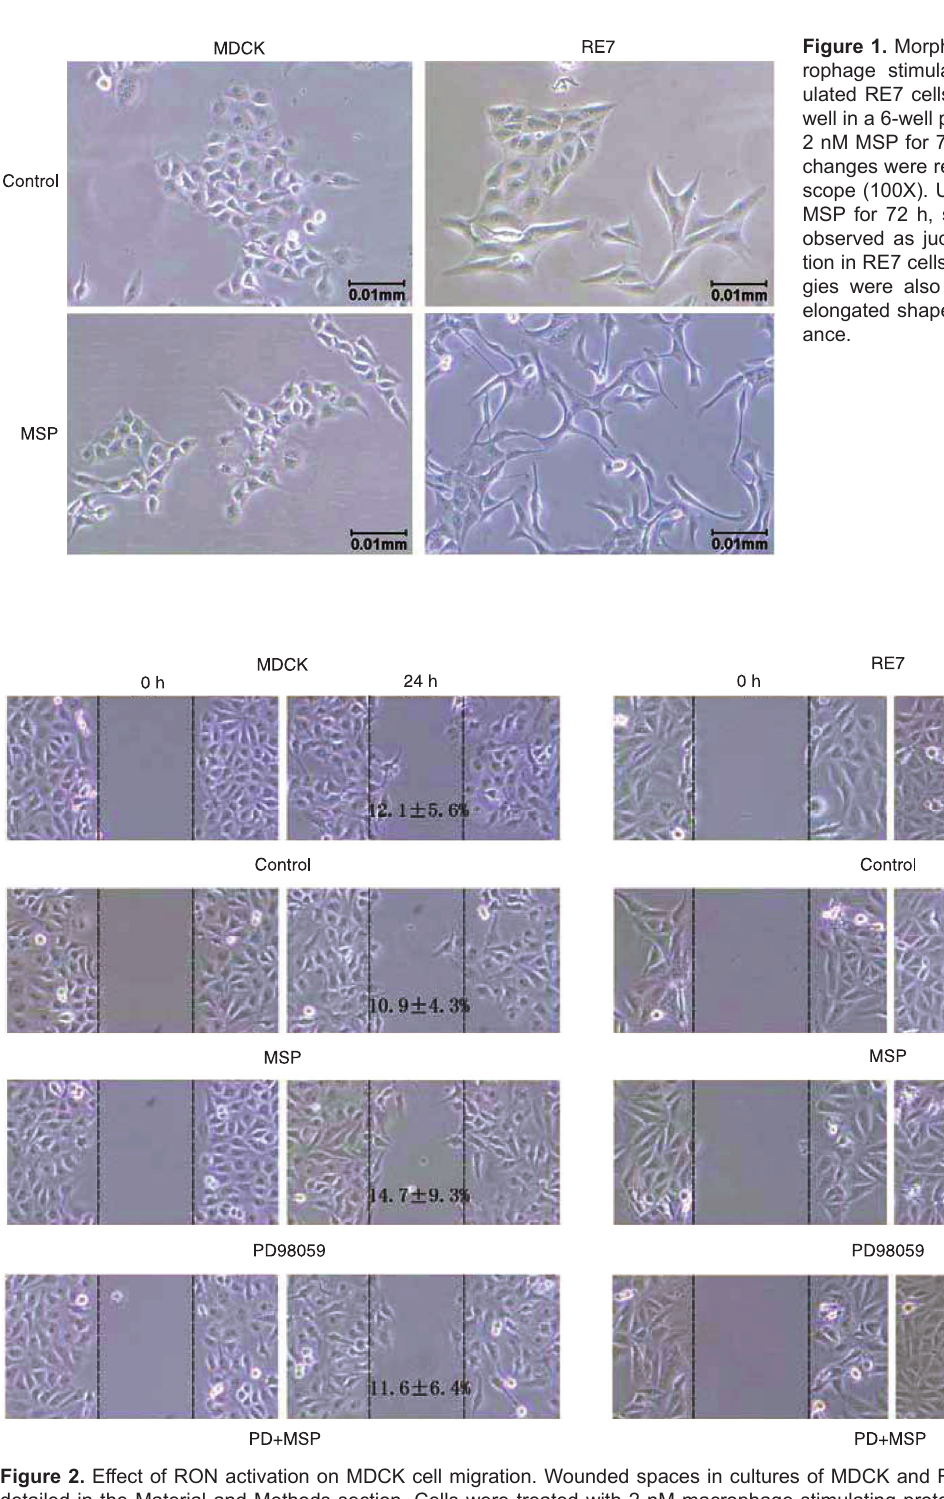
Figure 2. Effect of RON activation on MDCK cell migration. Wounded spaces in cultures of MDCK and RE7 cells were created as detailed in the Material and Methods section. Cells were treated with 2 nM macrophage stimulating protein (MSP) in the presence or absence of 50 μM PD98059 (PD). The covered areas were calculated. Cell migration data are reported in the photos, which were taken at 0 and 24 h after incubation. Stimulation of cells with MSP resulted in increased RE7 cell migration, while PD98059 showed inhibitory effects on RE7 cell